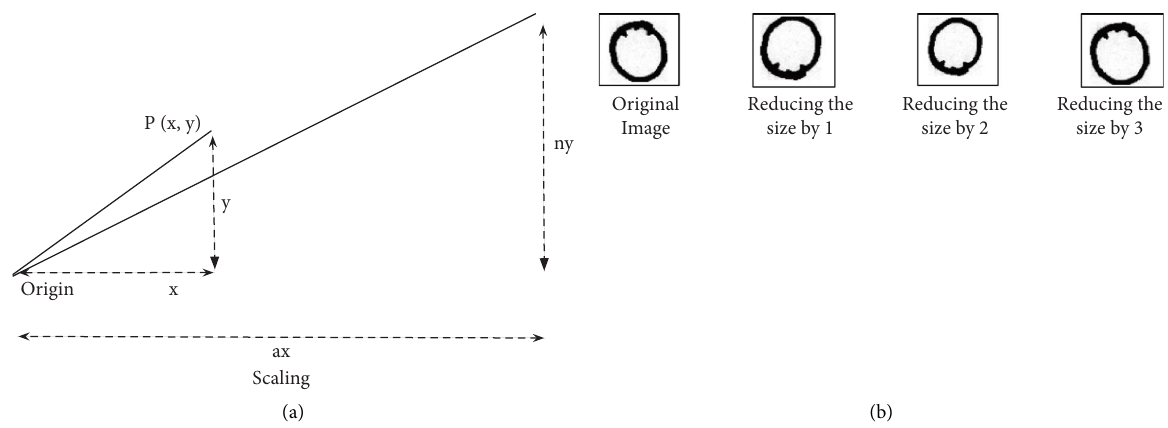
Figure 5: (a) Process of scaling technique. (b) Example of original and scaled images. Table 5: Efect of reducing size by scaling on performance. s is the parameter describing the amount of reduction. Model